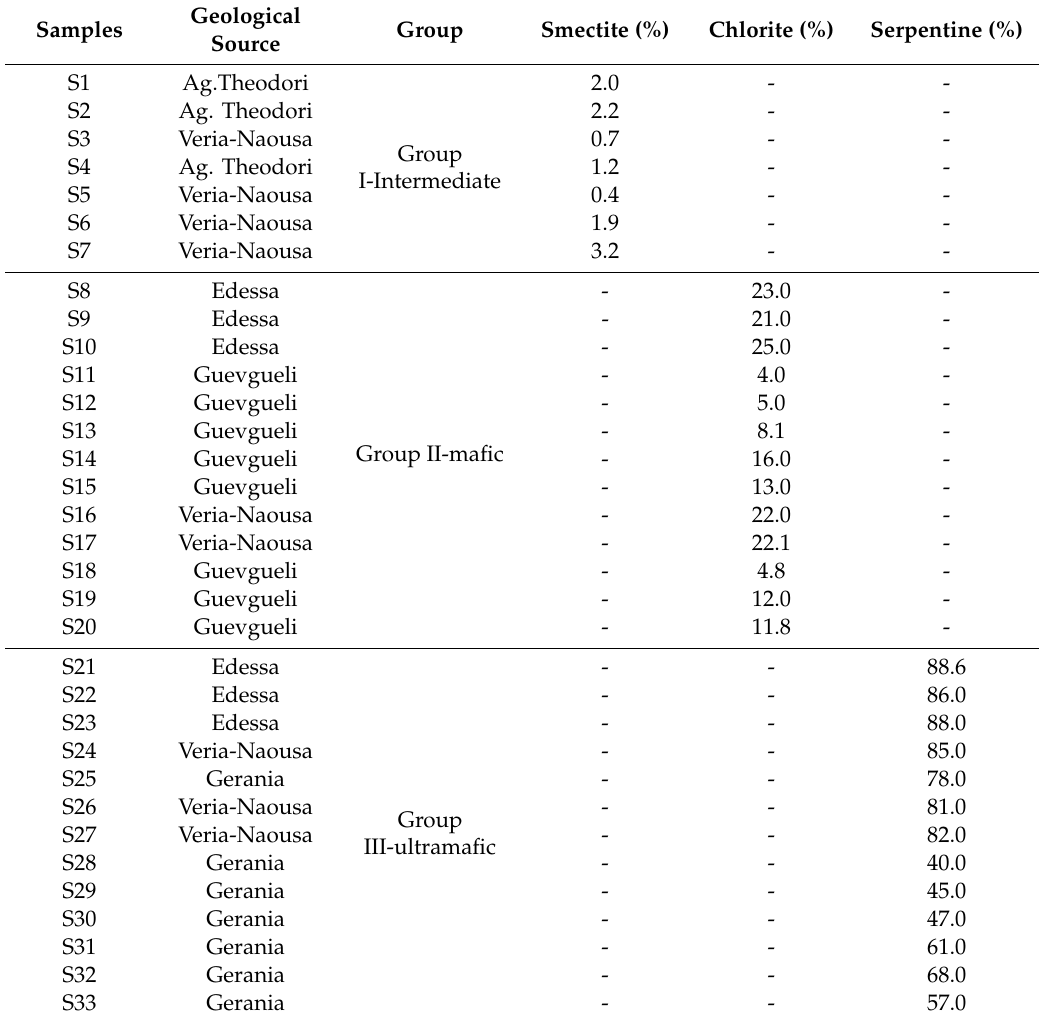
wt.% were calculated according to Bish and Post